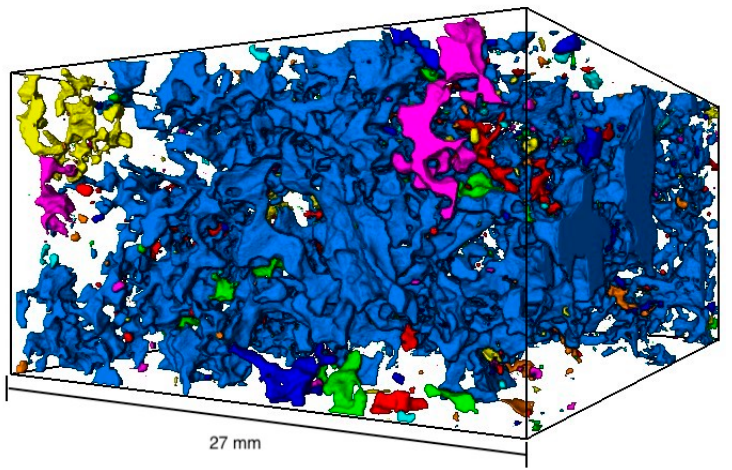
Figure 10. Grinding of asphalt concrete (AC)—asphalt petrology. Recorded scan ( left ) and vertical void distribution ( right ); area: 6.044 mm 2.